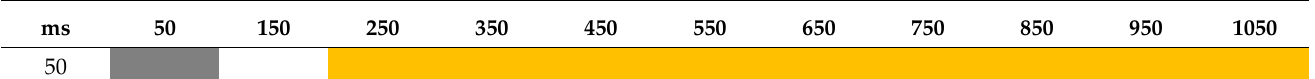
Figure A4. RMSE ( left ) and cross-correlation ( right ) of Etot algorithm for different window sizes. Table A4. Statistical significance between window sizes for Etot algorithm. Green indicates statisti- cally significant difference ( p < 0.05; Bonferroni-corrected) for the RMSE metric, and orange indicates significant difference ( p < 0.05; Bonferroni-corrected) for the cross-correlation metric. Grey indicates diagonal fields.